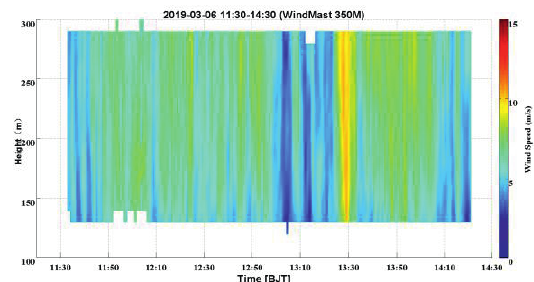
Figure 4. Wind THI diagram from 11:30 to 14:30BJT on 6 March 2019 observed by 350-M